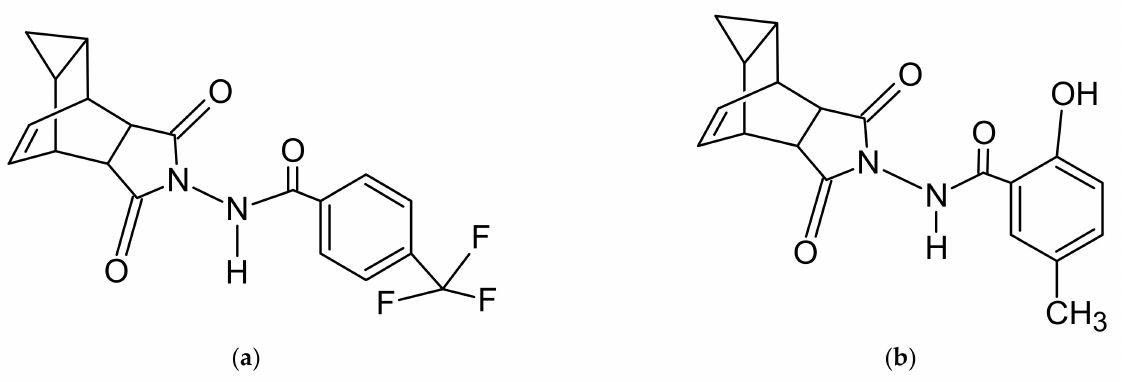
Figure 1. Chemical structure of ST-246 (tecovirimat) ( a ) and IS ( b ). The mass spectrometric analysis was carried out in electrospray negative ion mode. Multiple reaction monitoring (MRM) mode was chosen for ST-246 (tecovirimat) quantifi- cation and structure confirmation. Transition m/z 375.1 → 283.1, which generated a more intense signal, was employed for ST-246 (tecovirimat) quantification, whereas transitions m/z 375.1 → 188.2 and 375.1 → 96.1 were used for the structure confirmation (Figure 2a). The m/z 337.2 → 245.2 transition was selected for IS quantification, whereas transitions m/z 337.2 → 188.1 and 337.2 → 111.0 for the confirmation of IS structure (Figure 2b).